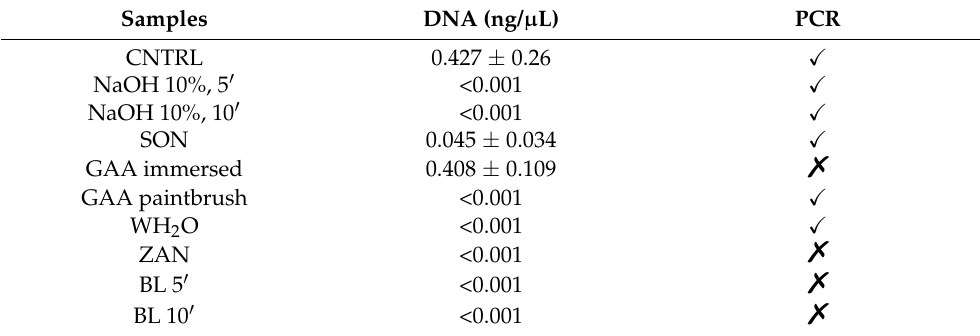
Table 2. Quantifications of DNA (average ± stdev) extracted from the first group of puparia cleaned immediately after adults’ emergence (CNTRL = control; NaOH = sodium hydroxide; SON = sonica- tion; GAA = glacial acetic acid; WH 2 O = warm water and soap; ZAN = hydrochloric acid/sodium bicarbonate solutions; BL = bleach; (cid:88) positive results for the expected fragment, (cid:37) negative results for the expected fragment).